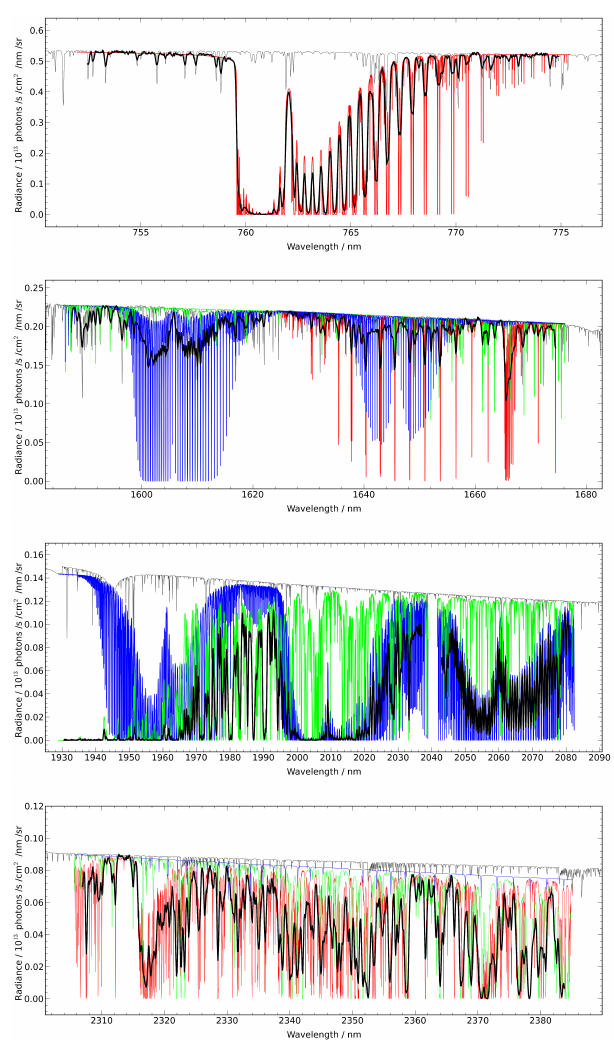
Figure 3. Backscattered radiance spectra for G3E’s NIR (upper), SWIR-1 (upper middle), SWIR-2 (lower middle), and SWIR-3 (lower) channels. The thin light gray spectrum in the background is the solar Fraunhofer spectrum (scaled to fit the figure, in arbitrary units), the black bold lines in the foreground are simulated G3E measurements for the reference scene with SZA = 70 ◦ and albedo 0.1, assuming a Gaussian instrument response function. The colored thin lines illustrate absorption by various molecular absorbers as- suming single-molecule atmospheres at infinite spectral resolution. (upper) O 2 red; (upper middle) CO 2 blue, CH 4 red, H 2 O green; (lower middle) CO 2 blue, H 2 O green; (lower) CH 4 red, H 2 O green, CO blue. Spectral windows are not exactly the ones listed in Table 1 but the ones used for retrieval